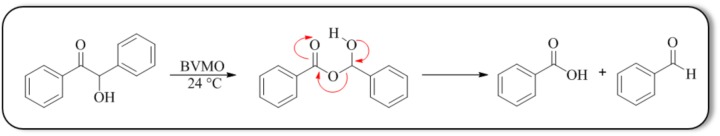
Proposed reaction of benzoin oxidation by Sle_62070. Mechanism of the hydrolysis of oxidation product to benzaldehyde and benzoic acid.